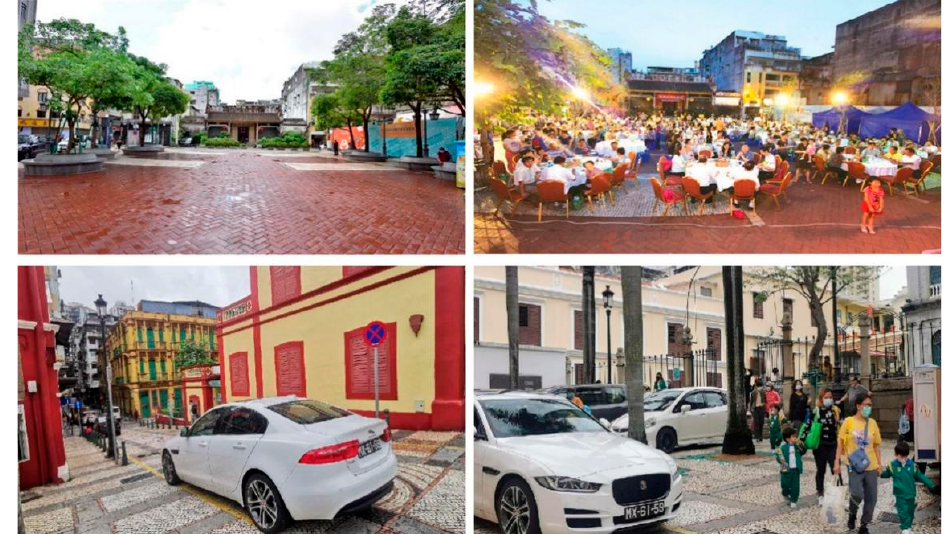
Figure 16. Largo do Pagode do Bazar and Adro de S. Lázaro.